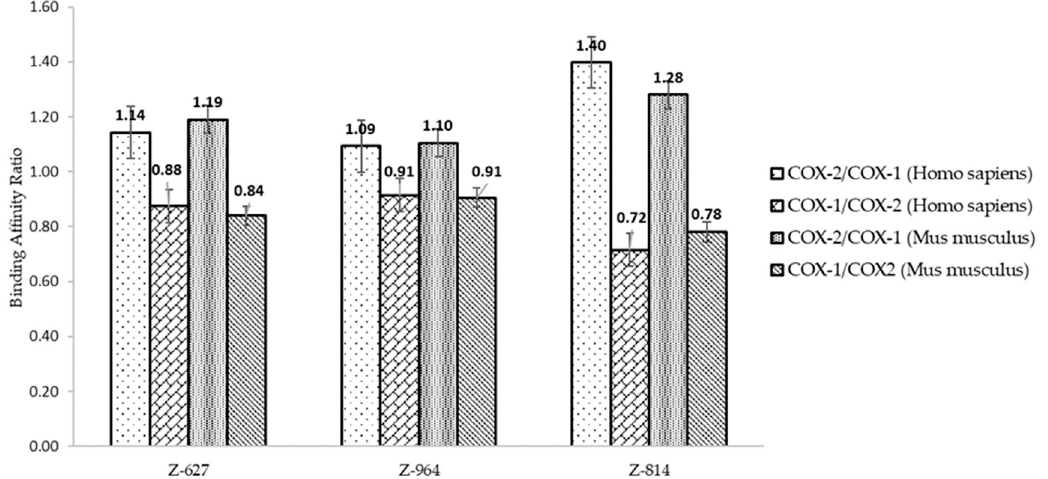
Figure 10. Binding affinity ratio of the selected structures.